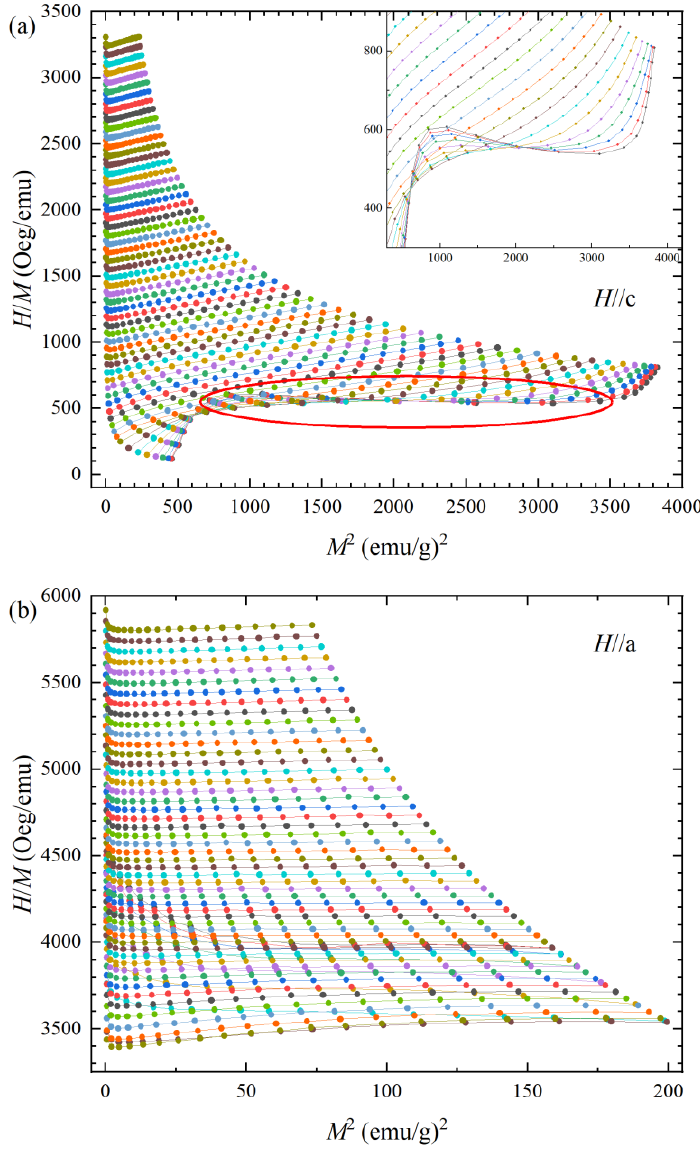
Figure 6. Arrott plots H/M versus M 2 of NdAlGe H //c ( a ) and H //a ( b ). The consistent positive slope in the Arrott plot indicates that the temperature-de- pendent magnetization of the material is in the second-order magnetic transition (SOMT). However, the presence of a metamagnetic spin reorientation induces a shift to a negative slope, indicating a first-order magnetic transition (FOMT). The alteration in transition or- der implies a fundamental difference in the MCE performance. The FOMT usually exhib- its a significantly higher maximum value of ∆ S M . The first elucidation of MCE by A.O. Pecharsky [4] also observed FOMT of the Gd 5 Si 2 Ge 2 , leading to the highest MCE perfor- mance at room temperature. In contrast, SOMT materials exhibit a relatively broad δ FWHM but lower maximum of ∆ S M . Therefore, the coexistence of FOMT and SOMT has a synergy to increase the entropy change as well as broaden the operating temperature range due to the large temperature width δ FWHM .